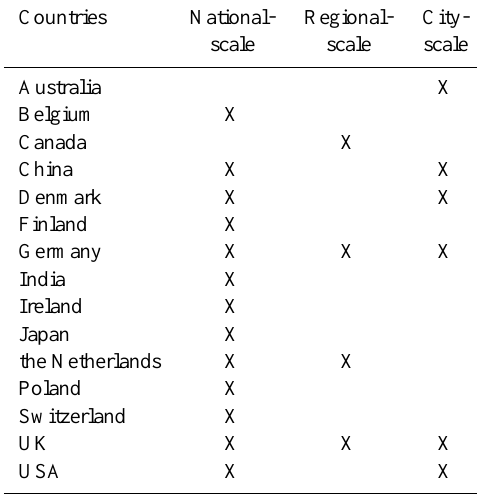
Table 3. Countries for which indications of the presence of pol- icy/legal standards of protection at national, regional or city scale were